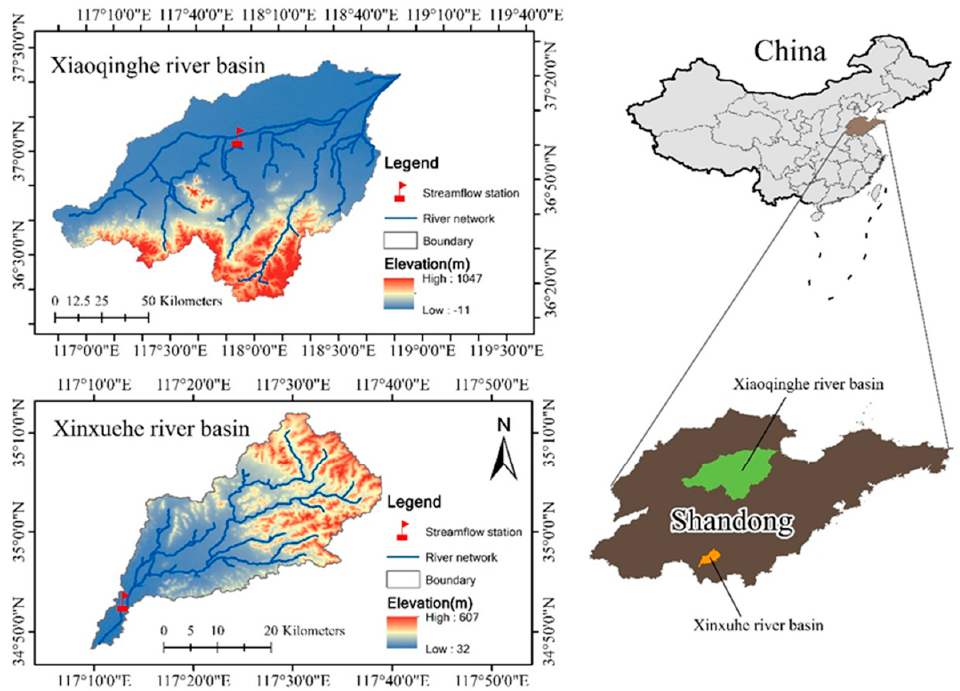
Figure 1. Xiaoqing River basin and Xinxue River basin, Shandong province, China.